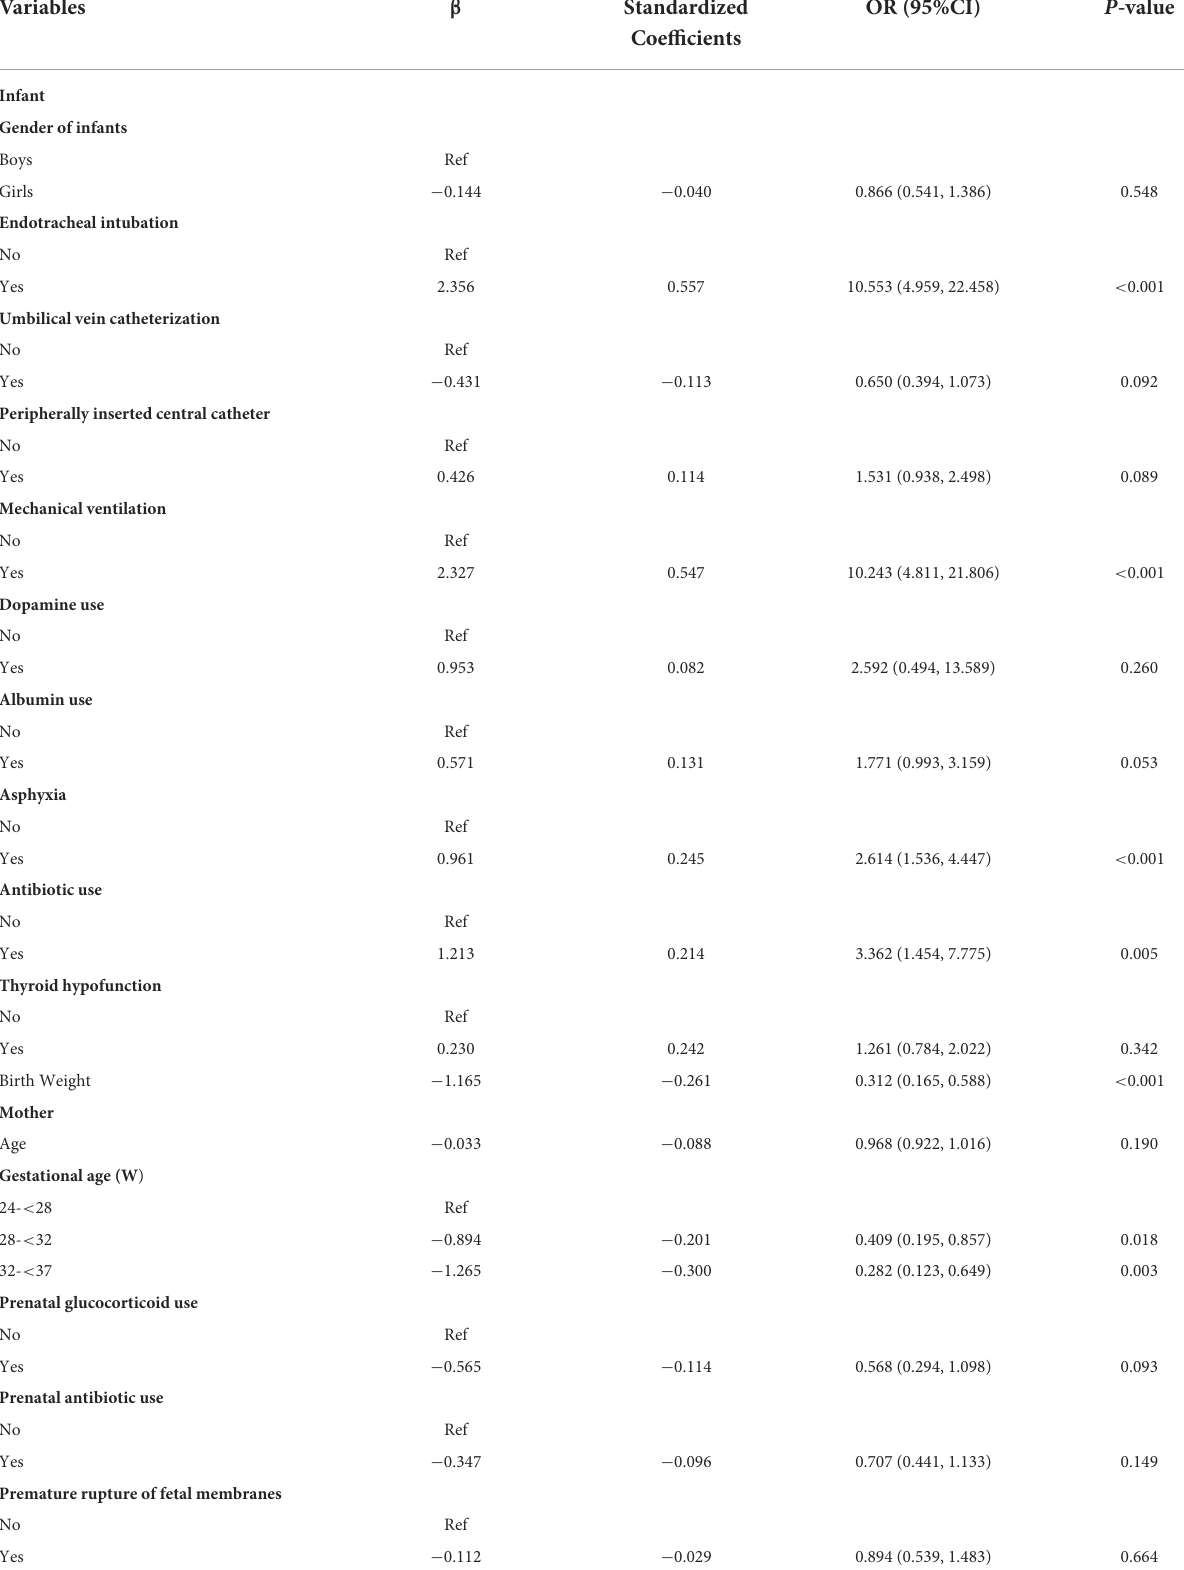
TABLE 3 The potential predictors for the risk of late-onset sepsis in premature infants. Variables β Standardized